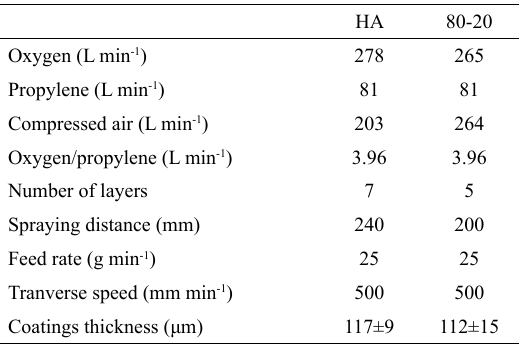
Table 1. Spraying parameters used to build up the coatings and coatings